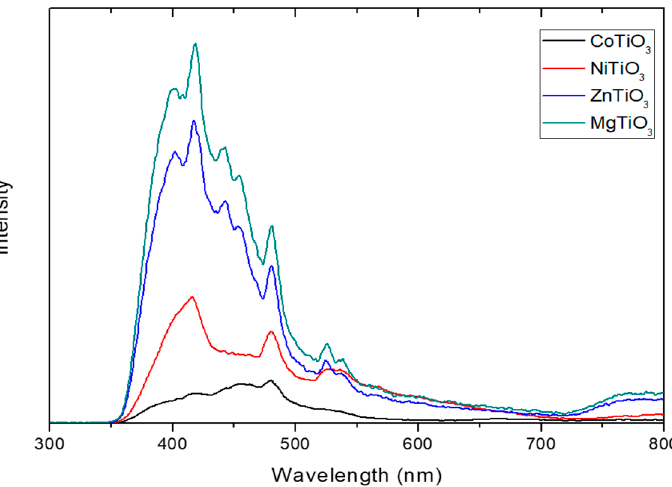
Figure 7. PL spectra of metal titanate nanorods ATiO 3 (A = Mg, Co, Ni, Zn) upon 330 nm excitation.